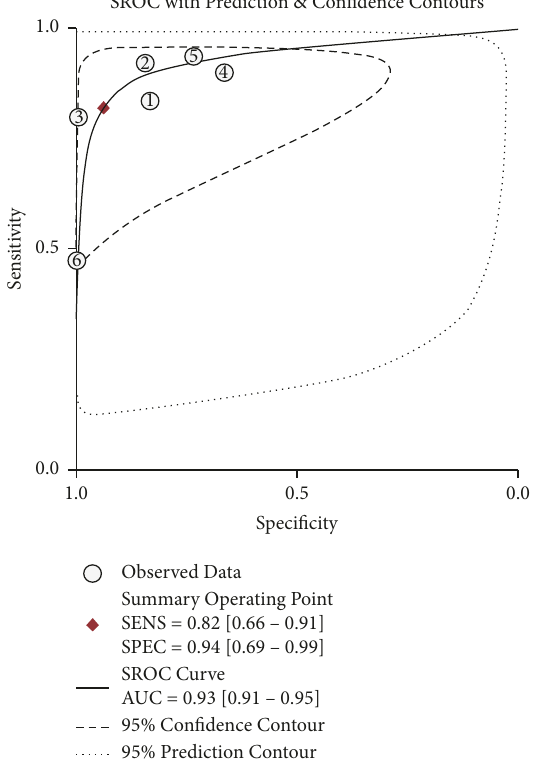
Figure 7: Summary ROC (SROC) curves of the diagnostic efficacy of the Cho/NAA ratio of the radiation injury group and the recurrent glioma